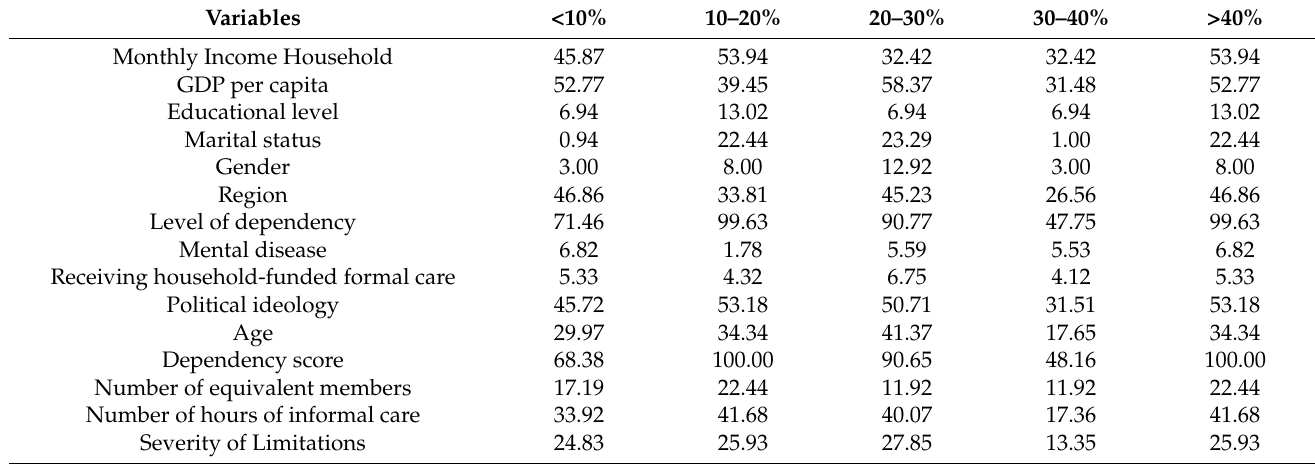
Table 5. Importance of variables in